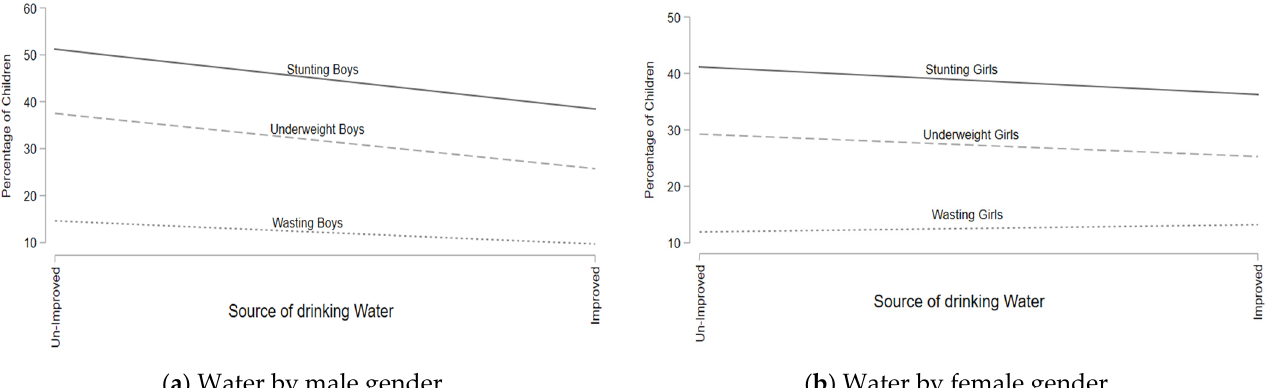
Figure 3. Prevalence rates of stunting, wasting, and being underweight for water source (disaggre- gated by child gender).